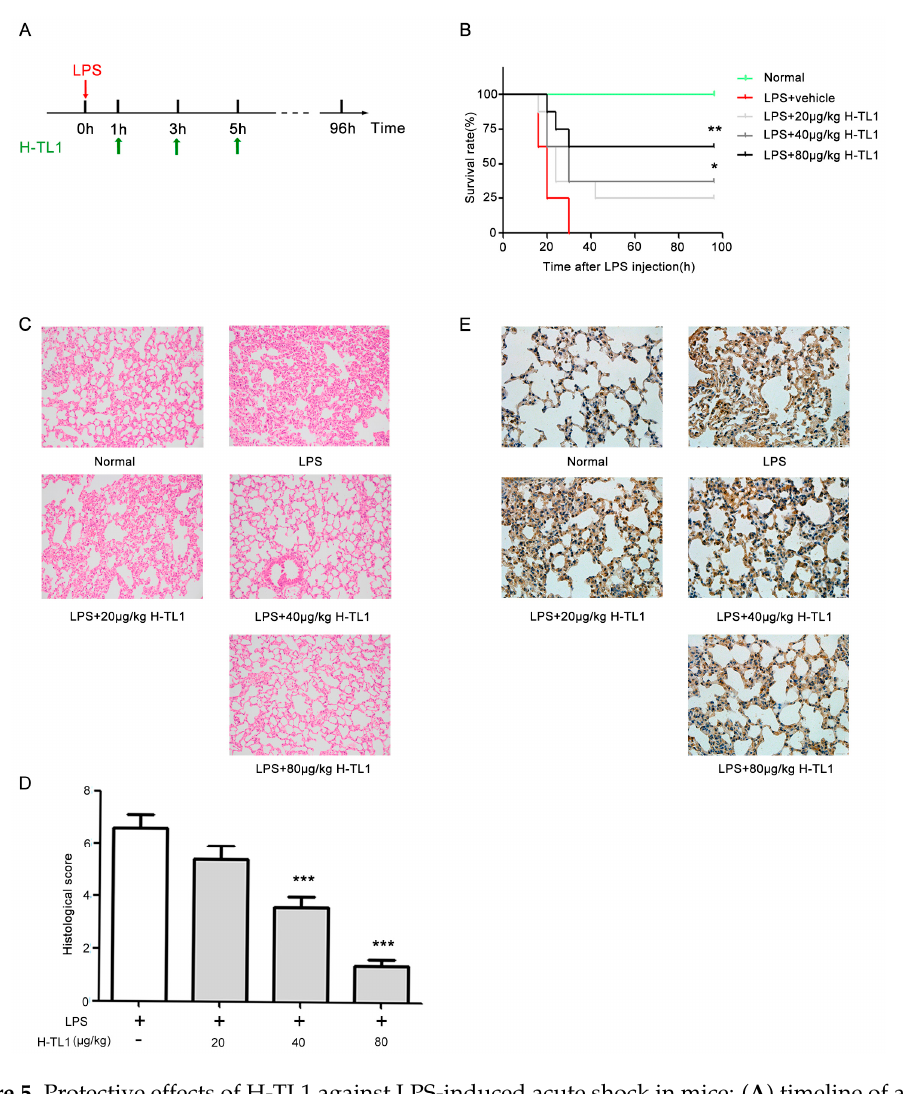
Figure 5. Protective effects of H-TL1 against LPS-induced acute shock in mice: ( A ) timeline of acute septic shock mouse model and treatment with H-TL1; ( B ) survival rates of mice were measured within 96 h. Group without LPS was considered normal, * p < 0.05 and ** p < 0.01 vs. LPS group (log-rank test); ( C ) effects of H-TL1 on LPS-induced lung tissue histological damage; ( D ) histological score of lung tissue samples; and ( E ) effects of H-TL1 on LPS-induced expression of TNF- α in lung tissue samples. Values represent means ± SEM ( n = 8), *** p < 0.001 vs. LPS group (ANOVA). H&E staining, 200× magnification; IHC, 400× magnification.